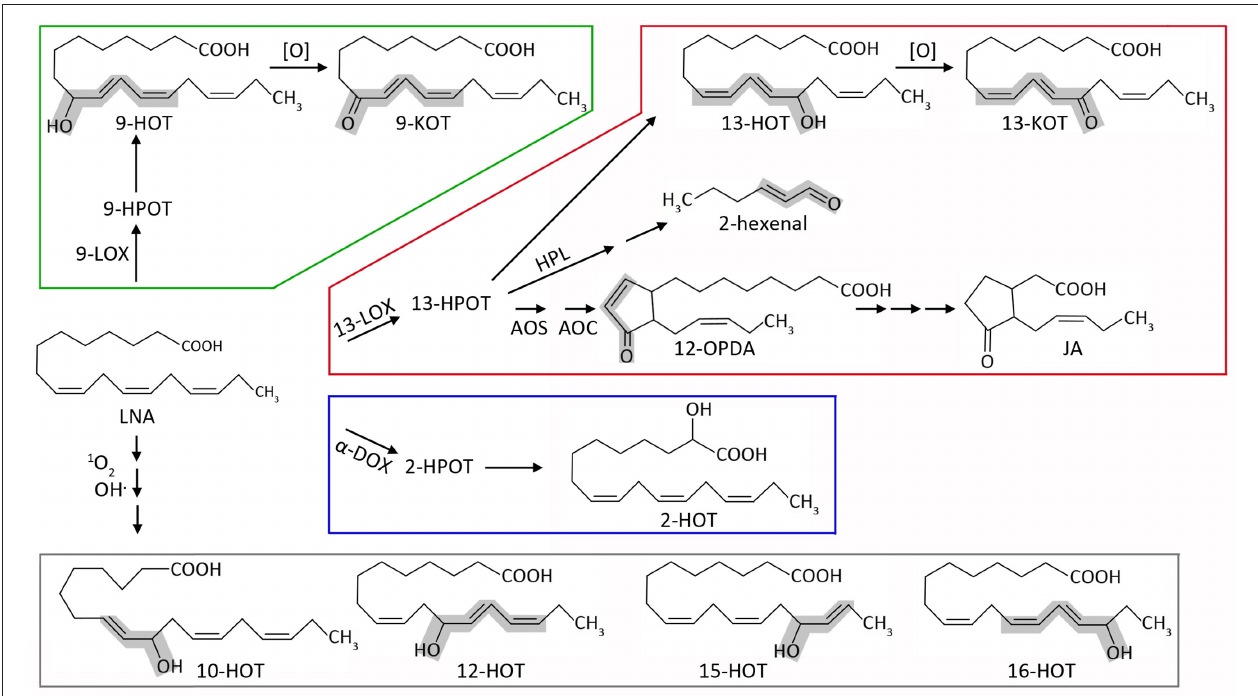
FIGURE 1 | Schematic representation of the major oxylipin biosynthesis pathways, focused on the derivatives used in this work. Starting from linolenic acid (LNA), oxygenation can be carried out by 9-lipoxygenases (9-LOX, green), 13-lipoxygenases (13-LOX, red), α -dioxygenases ( α -DOX, blue), or non-enzymatic reactions (gray). Lipoxygenases generate the hydroperoxides 9-HPOT and 13-HPOT, which are then reduced to hydroxyl-acids 9-HOT and 13-HOT. These can be further oxidized to 9-KOT and 13-KOT (alternatively, lipoxygenases could directly generate keto-acids from hydroperoxides, which is not shown for simplicity). 13-HPOT can be fragmented by hydroperoxide lyase (HPL) to 2-hexenal or committed to the jasmonate pathway by the sequential action of allene oxide synthase (AOS) and allene oxide cyclase (AOC) leading to 12-OPDA. The latter can be reduced and subjected to three β -oxidation cycles leading to jasmonic acid (JA). α -dioxygenases mainly yield 2-HOT in vivo , also through a hydroperoxide intermediate (2-HPOT). LNA can also react directly with singlet oxygen or hydroxyl radical. This pathway can lead to 9-HOT and 13-HOT (not shown), but also to oxylipins exclusively generated by non-enzymatic reactions (10-HOT, 12-HOT, 15-HOT and 16-HOT). α , β -unsaturated carbonyl (RES) or hydroxyl (RES precursor) moieties are highlighted in gray. For simplicity, stereochemistry details have been omitted (e.g., 13-LOX and 9-LOX yield S -enantiomers whereas non-enzymatic reactions produce racemic mixtures) as well as additional oxylipins generated by secondary enzymatic or non-enzymatic